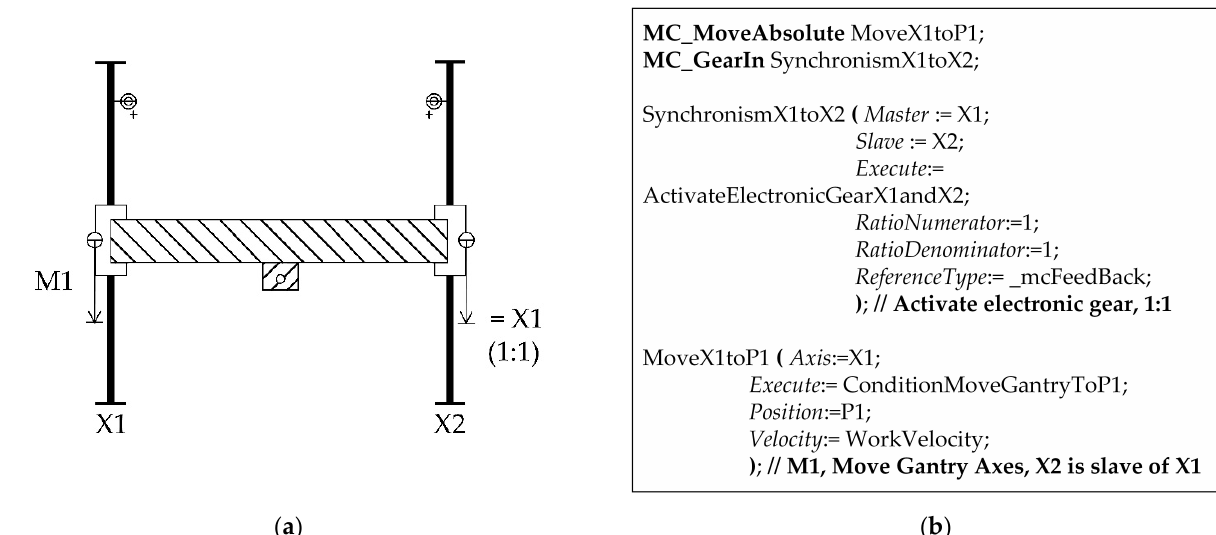
Figure 17. Two linear coordinated movements of the gantry machine. ( a ) Combination of mechanical simplification and path representation; ( b ) program in PLCopen.